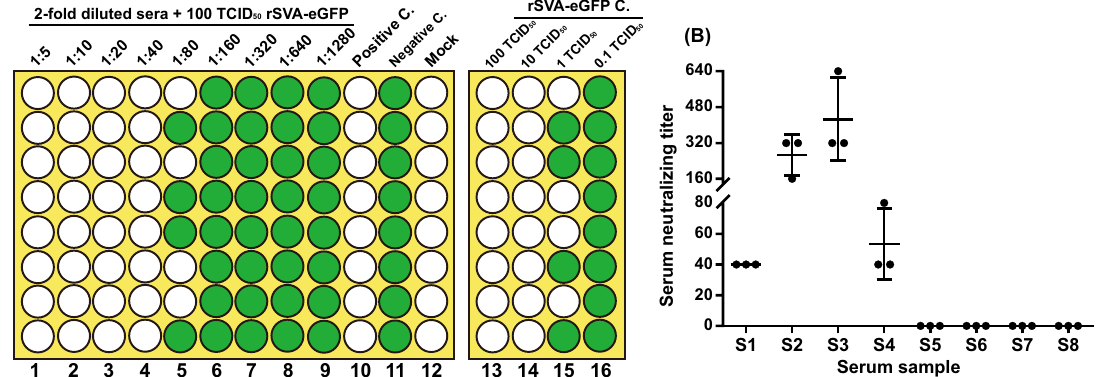
Figure 4. Development of rSVA-eGFP-based virus neutralization test (VNT) for analysis of serum samples. Schematic representation of 96-well plate format designed for performing rSVA-eGFP-based VNT ( A ), which shows a hypothetical result that the neutralization titer is determined to be 80 for a given serum sample. The neutralization titer is the dilution of serum that neutralizes rSVA-eGFP in half the wells of a given column. Green and white wells represent fluorescence-emitting and -free cell monolayers, respectively. C.: Control. VNT result of eight porcine serum samples ( B ), showing that S1, S2, S3 and S4 are neutralization titer-positive; S5, S6, S7 and S8 have no neutralizing